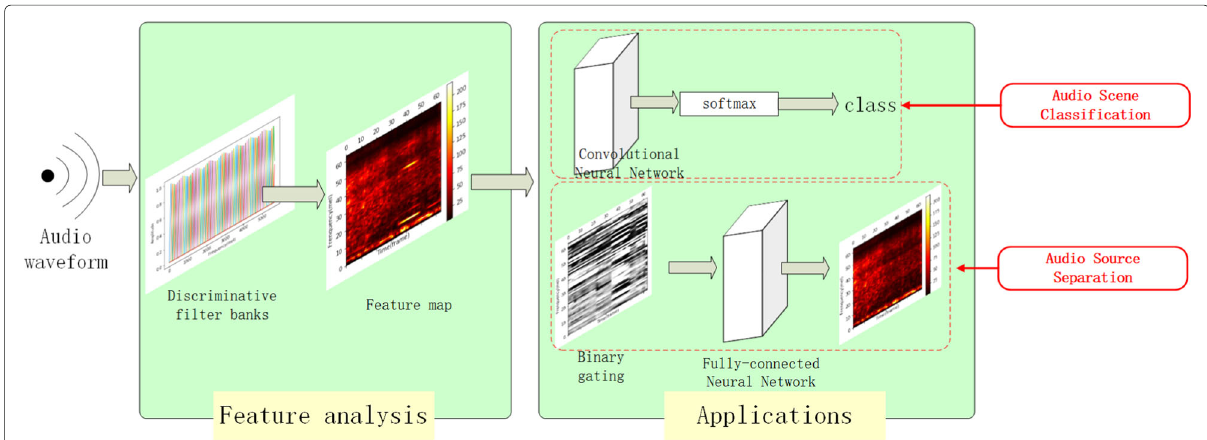
Fig.2 Discriminative filter bank learning framework. The left part of the framework is the feature analysis procedure including STFT and discriminative filter banks. The right part is the application example of the extracted feature map, such as audio scene classification and audio source separation. Discriminative filter banks in the feature analysis procedure and the back-end application modules are stacked into a deep neural